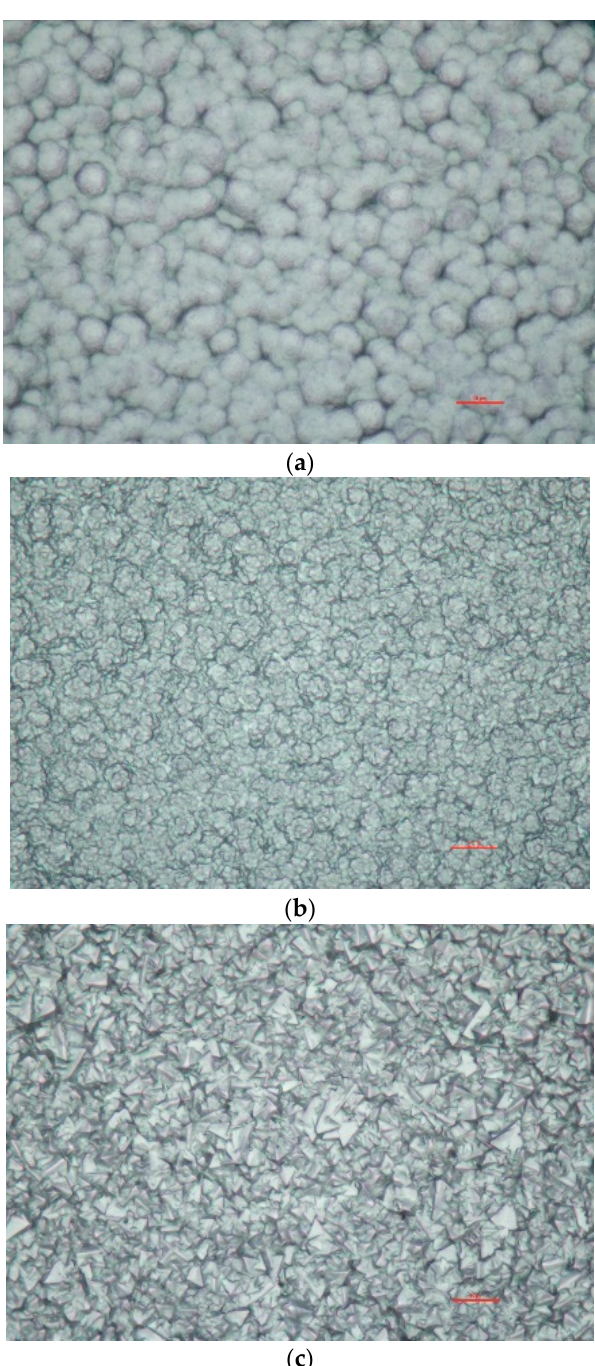
Figure 8. Examples of recent UNCD coatings by the company CarbonCompetence (total size of the samples: 124 × 89 µ m): ( a ) nanocrystalline diamond; ( b ) microcrystalline diamond (small grains); ( c ) microcrystalline diamond (medium-sized grains).